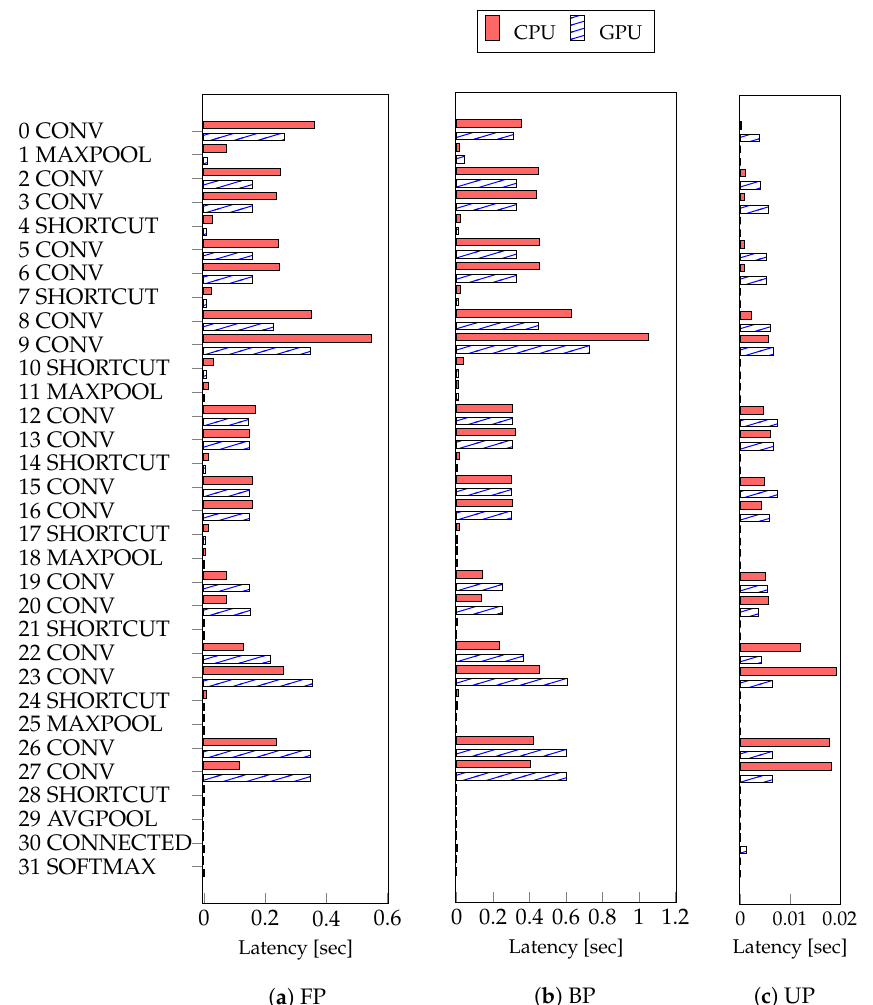
Figure 6. The result of profiling the latency performed by the CPU and GPU of each step. Forward propagation (FP); backpropagation (BP); and weights update (UP).